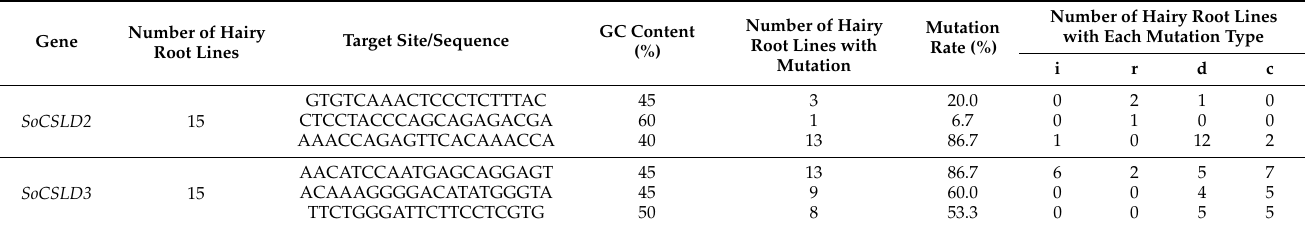
Table 1. Detailed information of the mutation types of different targets in SoCSLD2 and